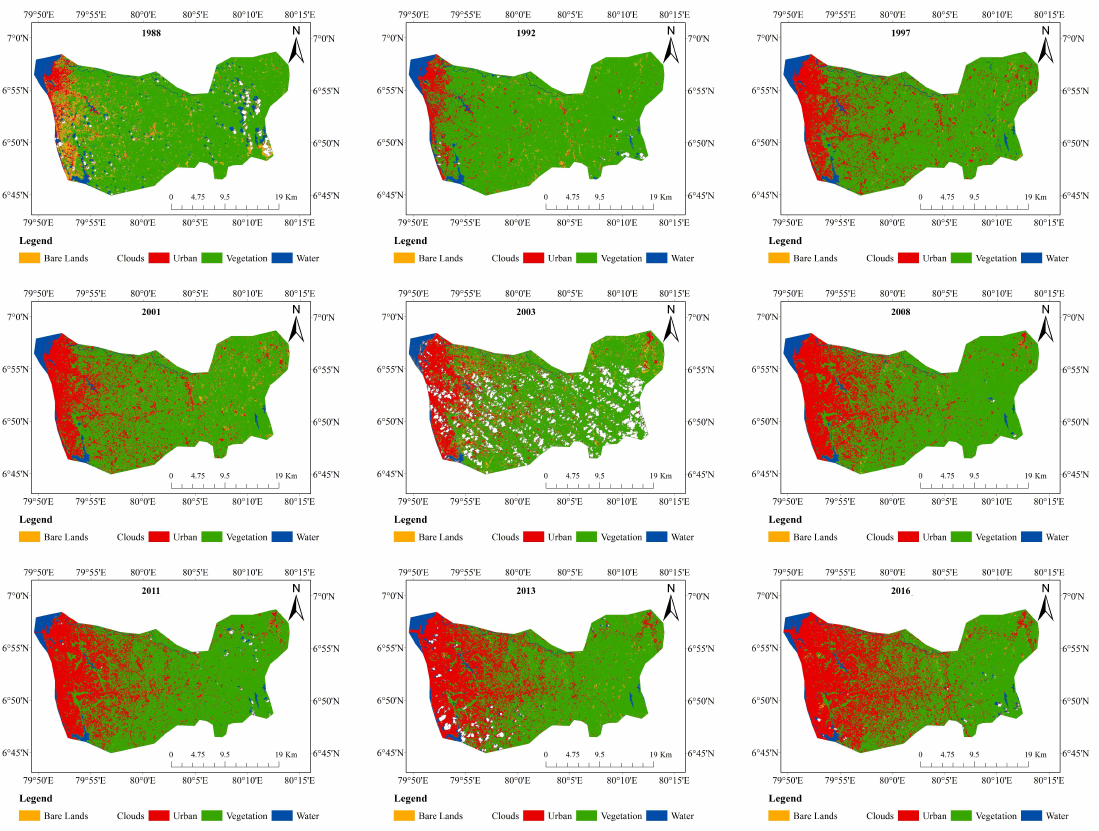
Figure 3. The results of classification using support vector machine (SVM) in Colombo between 1988 and